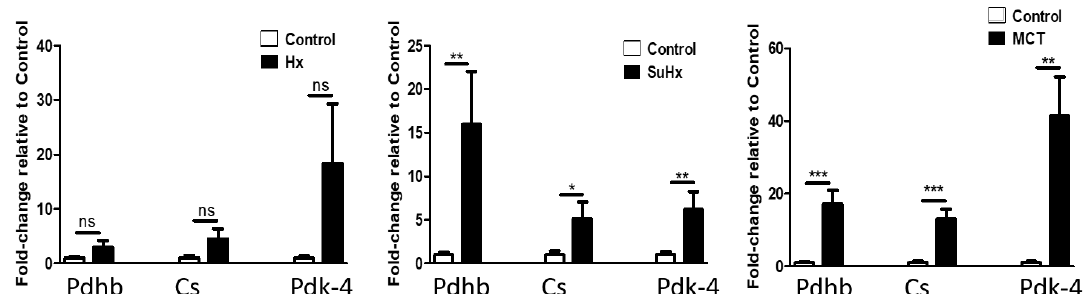
Figure 7. Altered adipose tissue levels of tricarboxylic acid cycle (TCA) marker mRNA in experimental pulmonary hypertension. Data represent mean ± SEM from n = 8–14 animals per experimental group. Statistical analysis by Student’s t -test. * p < 0.05, ** p < 0.005, *** p < 0.001, ns: no significant.